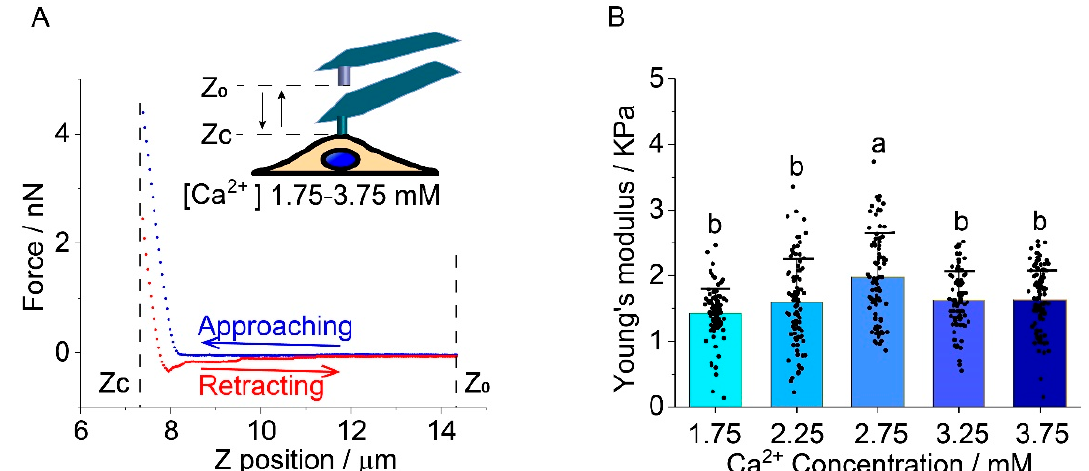
Figure 1. The effects of extracellular Ca 2+ concentration on human chondrocyte’s stiffness. ( A ) A representative AFM indentation curve measured for a chondrocyte cultured at 1.75 mM Ca 2+ concentration. Z0 is the initial position of the AFM tip, Zc is the constant holding position of the tip; ( B ) As the [Ca 2+ ] increases, from the normal physiological level (1.75 mM), the Young’s modulus of chondrocytes increases by 37% at 2.75 mM and declines at a higher Ca 2+ concentration. N = 90 cells/group are measured and analyzed. Group difference was detected with ANOVA and Tukey’s post hoc tests in GraphPad Prim 8. Letters (a, b) above the bars correspond to distributions that are (letters different) or are not significantly different (letter shared) at the p < 0.05 level.